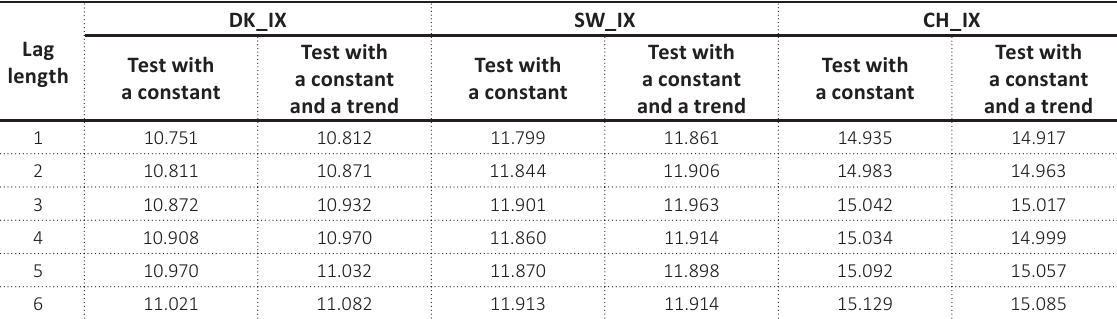
Table 4. Results of optimal lag via AIC for interest rates and blue chip stock indices